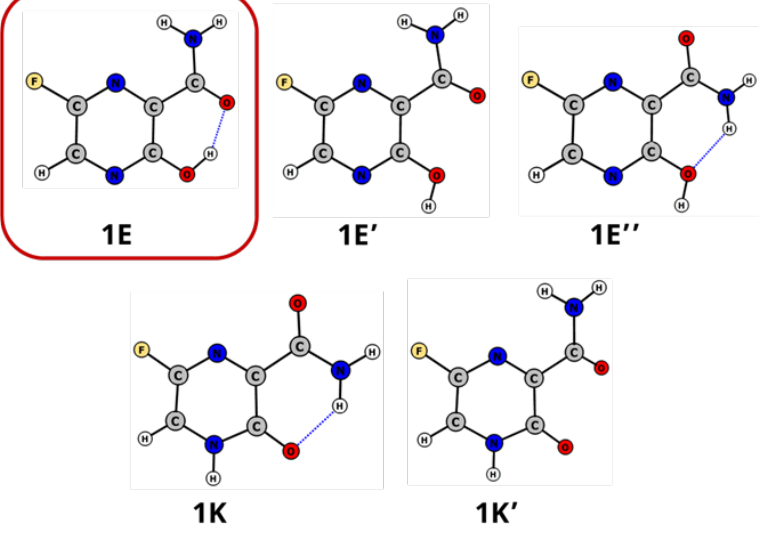
Figure 1. The most stable structures (M06-2X/def2-TZVPPD) of 1 in acetonitrile in the ground state (S 0 ) — E corresponds to the enol forms, while K corresponds to the keto tautomers. The corresponding relative energies of the structures (shown in Figure 1) are col- lected in Supplementary Table S2. In the case of the enol forms, the position of the OH proton is of importance, while the stabilization of the keto form depends on the orienta- tion of the amide group. As a result, the sufficient stabilization in the case of hydrogen bonding formation makes the 1E and 1K isomers, featuring intramolecular hydrogen bonding, most stable among the other possible isomers (see Supplementary Tables S1 and